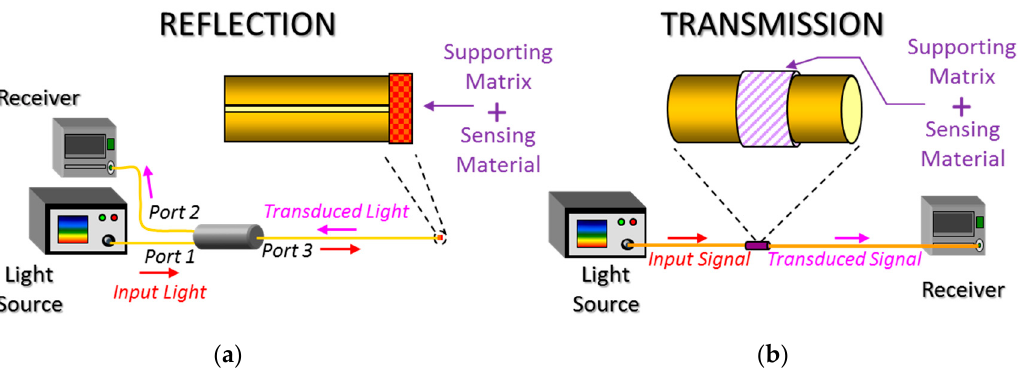
Figure 3. Architectures for intrinsic optical fibre sensors: ( a ) reflection and ( b ) transmission.